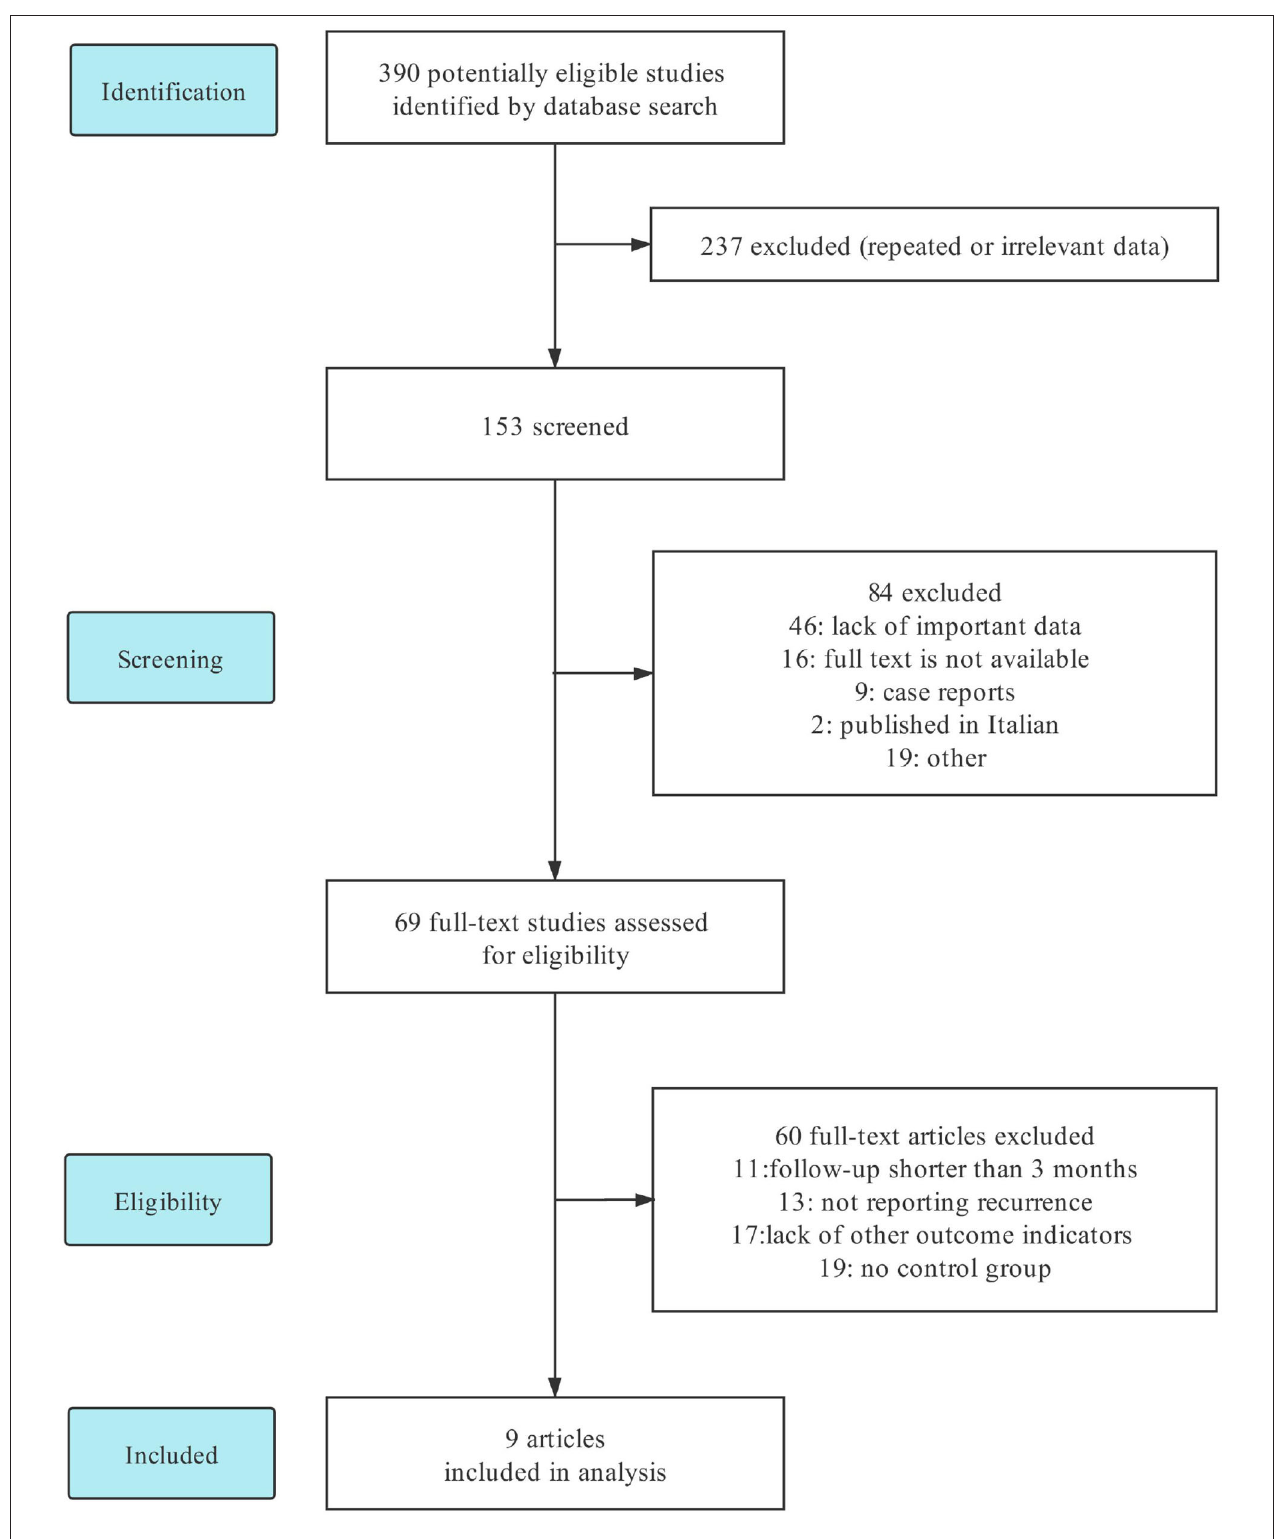
FIGURE 1 | Flow diagram showing selection of articles for this systematic review.